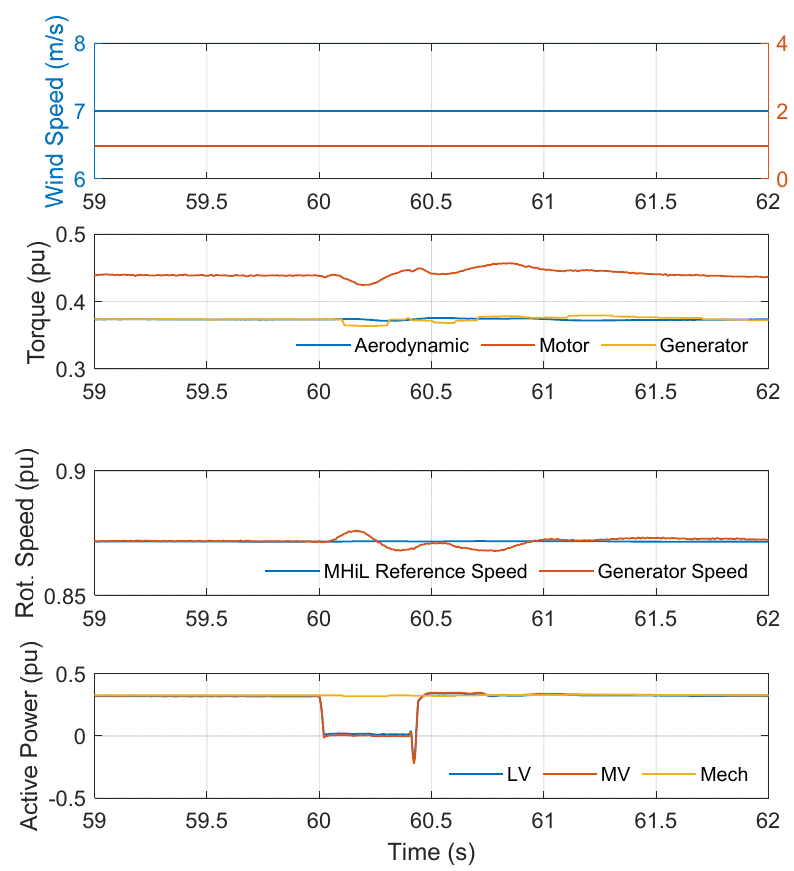
Figure 12. Mechanical quantities for 3 phase 0 pu UVRT in partial